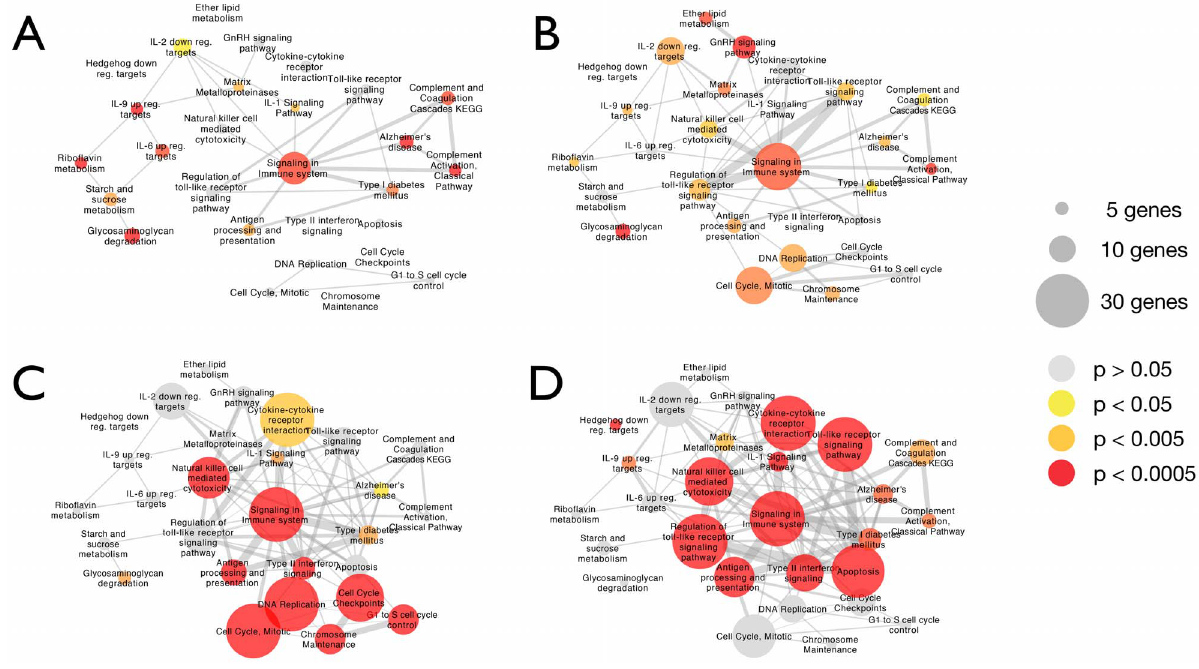
Figure 2. Comparison of all 4 identified studies at the pathway level. Pathway enrichment calculated using hypergeometric tests with all known pathways present in Netpath, Wikipathways, Kegg, and Reactome, with Cytoscape for visualization. 2a. Lai et al, 5 day exposure. 2b . Lai et al, 8 week exposure. 2c . Meng et al, 3 week exposure. 2d . Brass et al, 1 week exposure. doi:10.1371/journal.pone.0062910.g002 PLOS ONE |